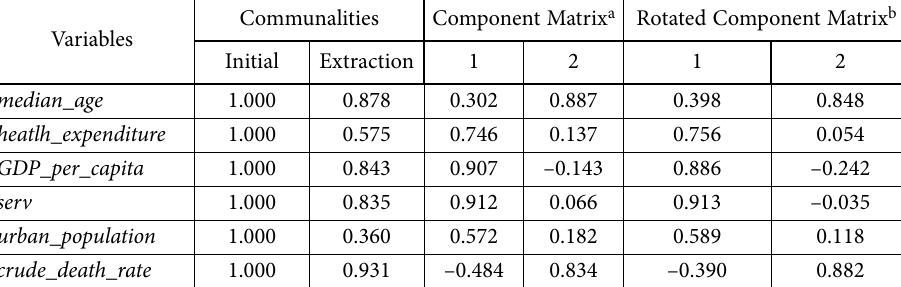
Table 6. Communalities and component loadings in the 2-component PCA (source: authors’ computa- tion using IBM SPSS Statistics 21)